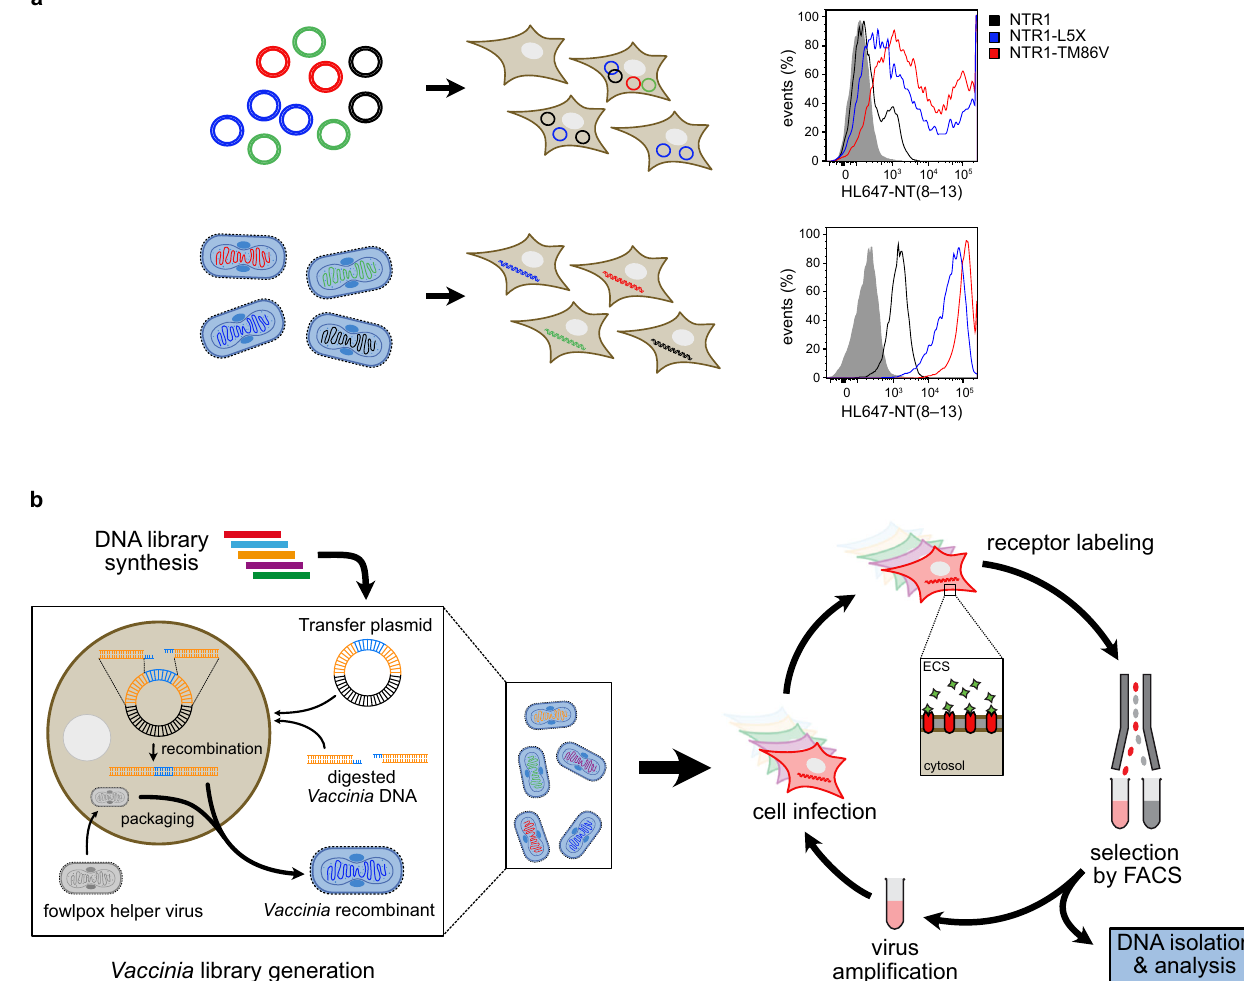
Fig. 1 | Creating a directed evolution system for GPCRs in mammalian cells. a ComparisonofGPCRexpressioninplasmid-transfectedand Vaccinia -transduced mammaliancells.Transiently transfected CHO cells (upper right panel),A431 cells infected with Vaccinia virus constructs (lower right panel). Negative control (gray shaded), NTR1 (black line), NTR1-TM86V (red line) and NTR1-L5X (blue line) are shown. b Work fl